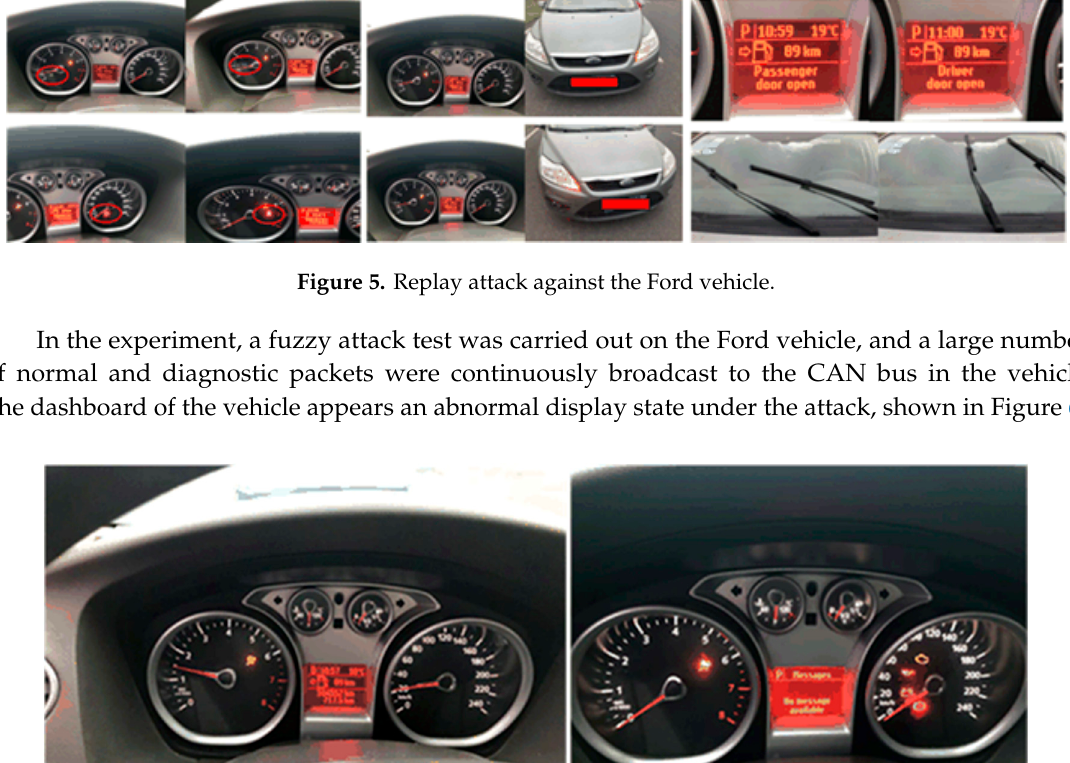
Table 4. Communication matrix of Ford vehicle.